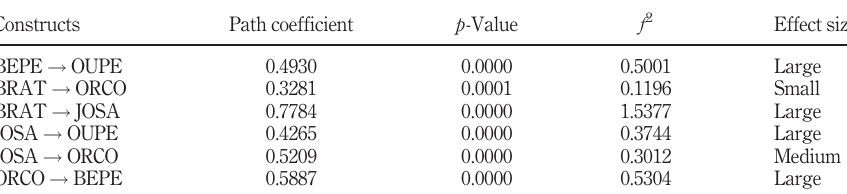
Table 4. Effects